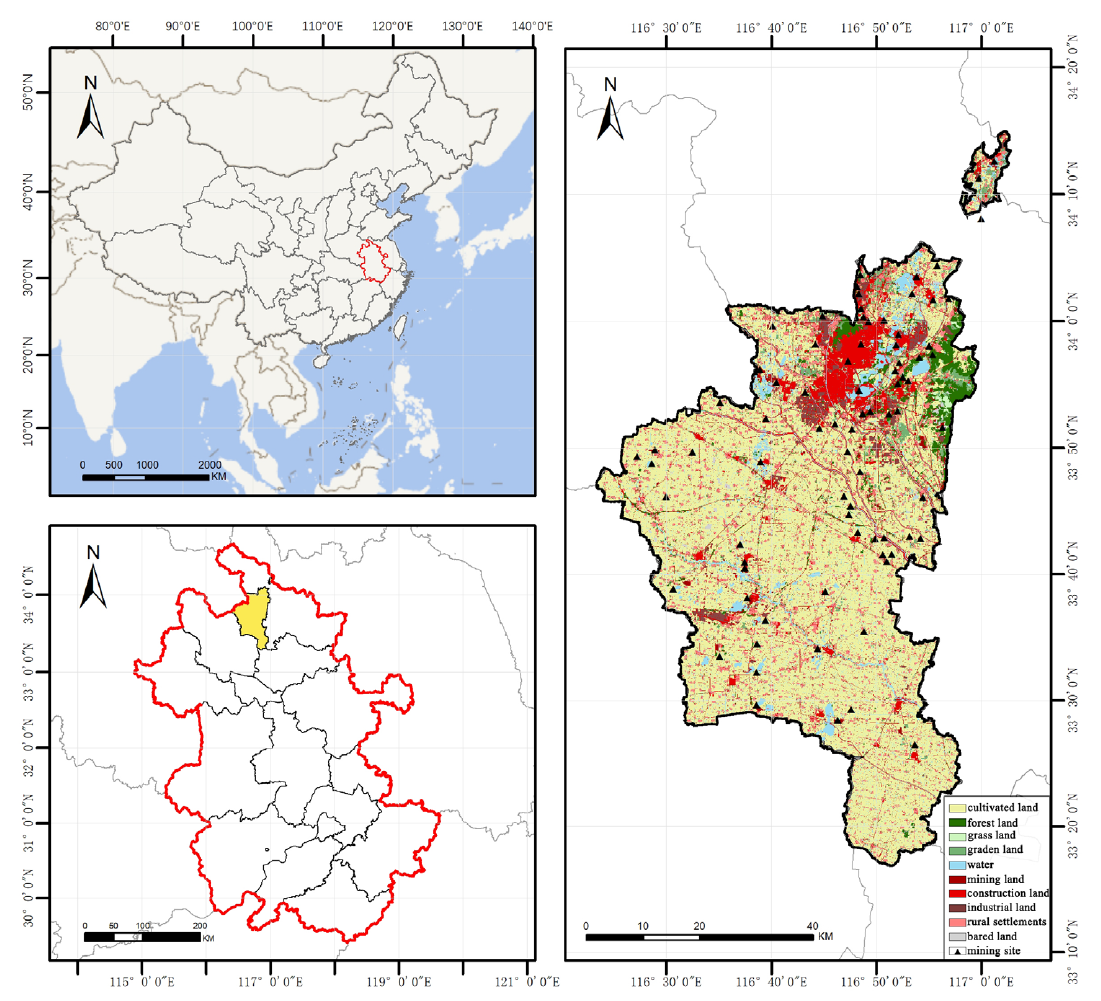
Figure 1. Location of Huaibei City.